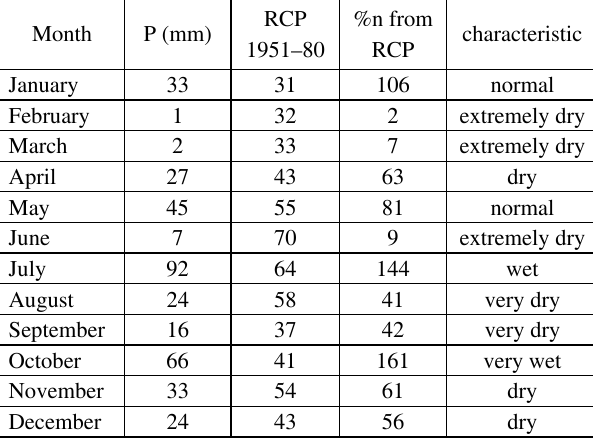
Table 2 . Evaluation of months according to rain reference cli- mate period (RCP) 1951–80 in Nitra for 2003